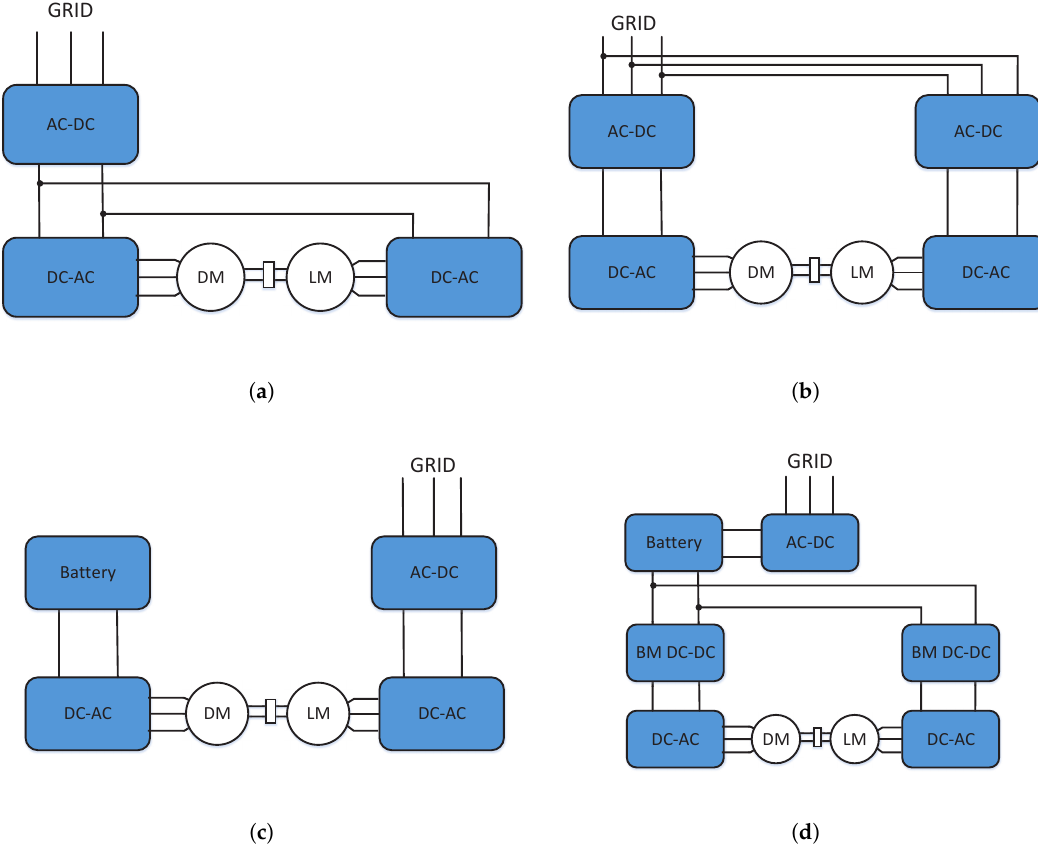
Figure 1. Simplified electrical schemes of electric powertrain testing system: ( a ) common DC-link; ( b ) separate AC–DC converters for drive and dynamometer; ( c ) battery-driven drive and grid connected dynamometer; ( d ) battery and two bidirectional multiphase DC–DC